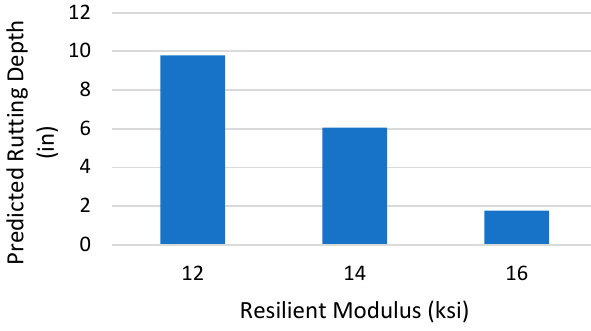
Figure 11. Model Sensitivity for Resilient